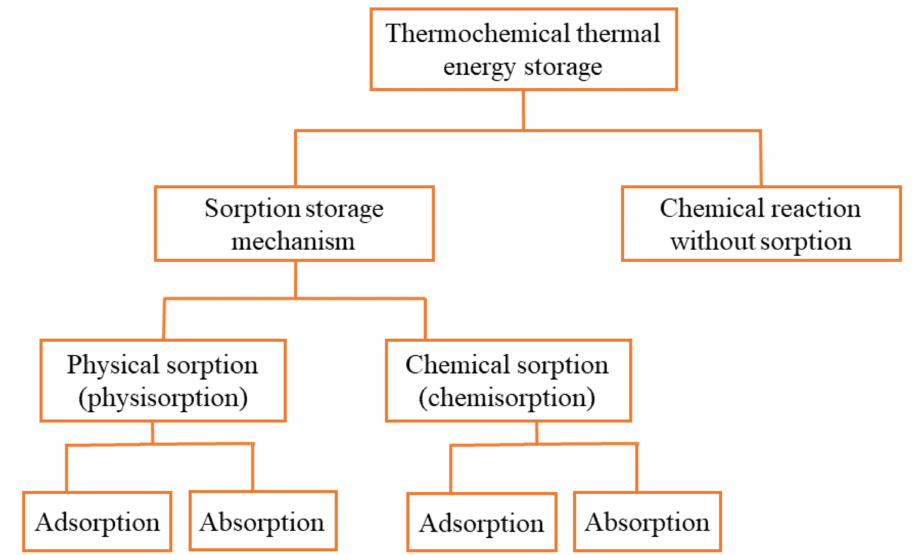
Figure 3. Different mechanisms of thermochemical heat storage